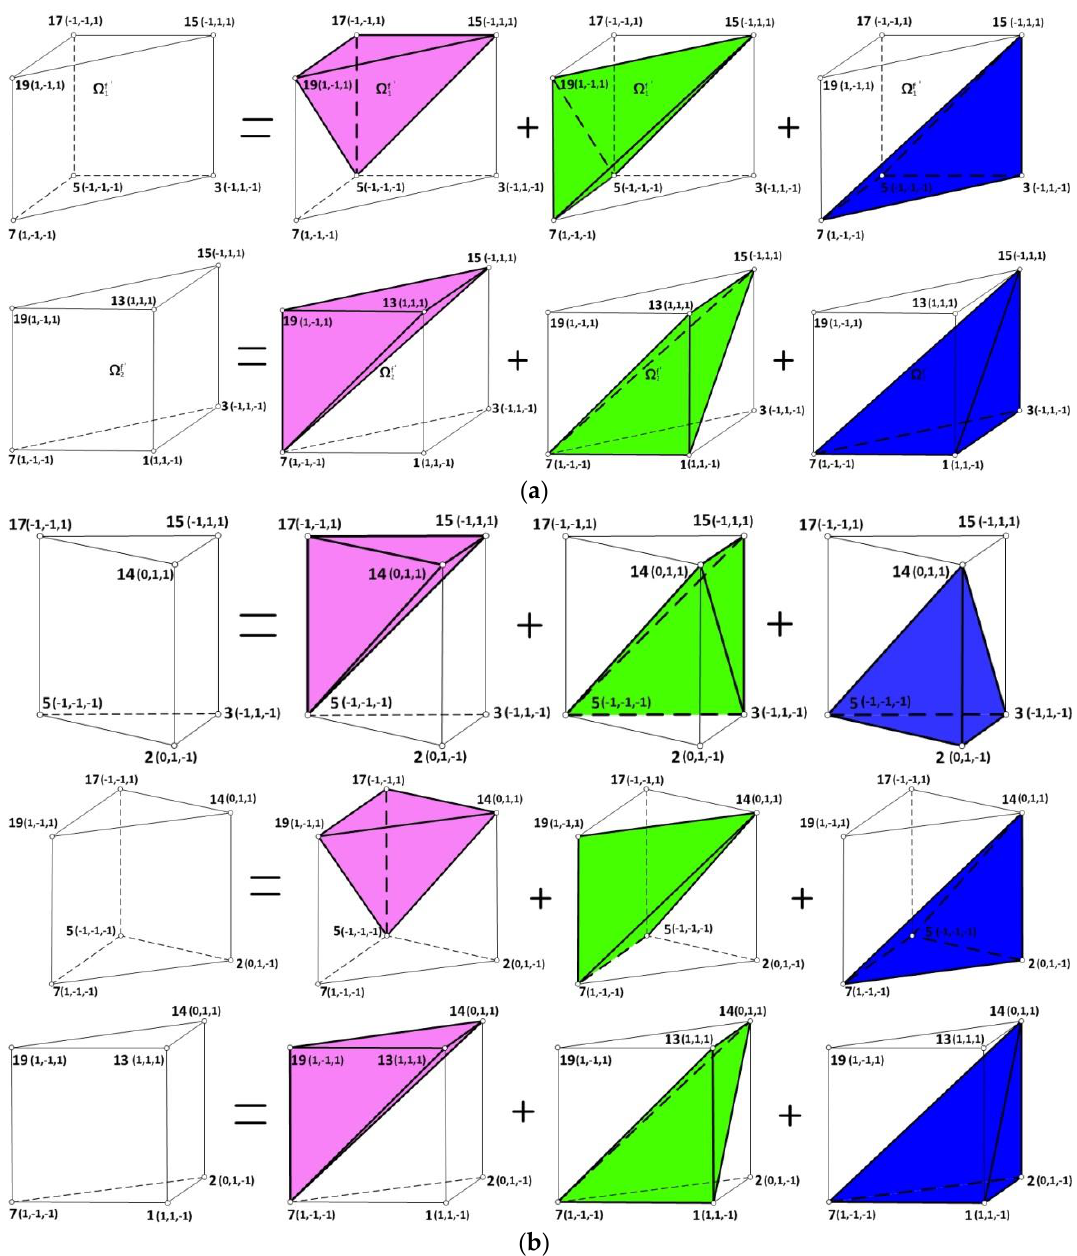
Figure 7. A subdivision of each triangular prism into three tetrahedral subcells after a subdivision of Ω f′ into two or three triangular prisms (see Figure 5b,c). ( a ) A subdivision of each triangular prism into three tetrahedral subcells at the singular point 15 after a subdivision of Ω f ′ into two triangular prisms (Ω 1f′ and Ω 2f′ ) (see Figure 5b,c); ( b ) a subdivision of each triangular prism into three tetrahedral subcells at the singular point 14 after a subdivision of Ω f ′ into three triangular prisms (Ω 1f′ , Ω 2f′ and Ω 3f′ ) (see Figure 5b,c).